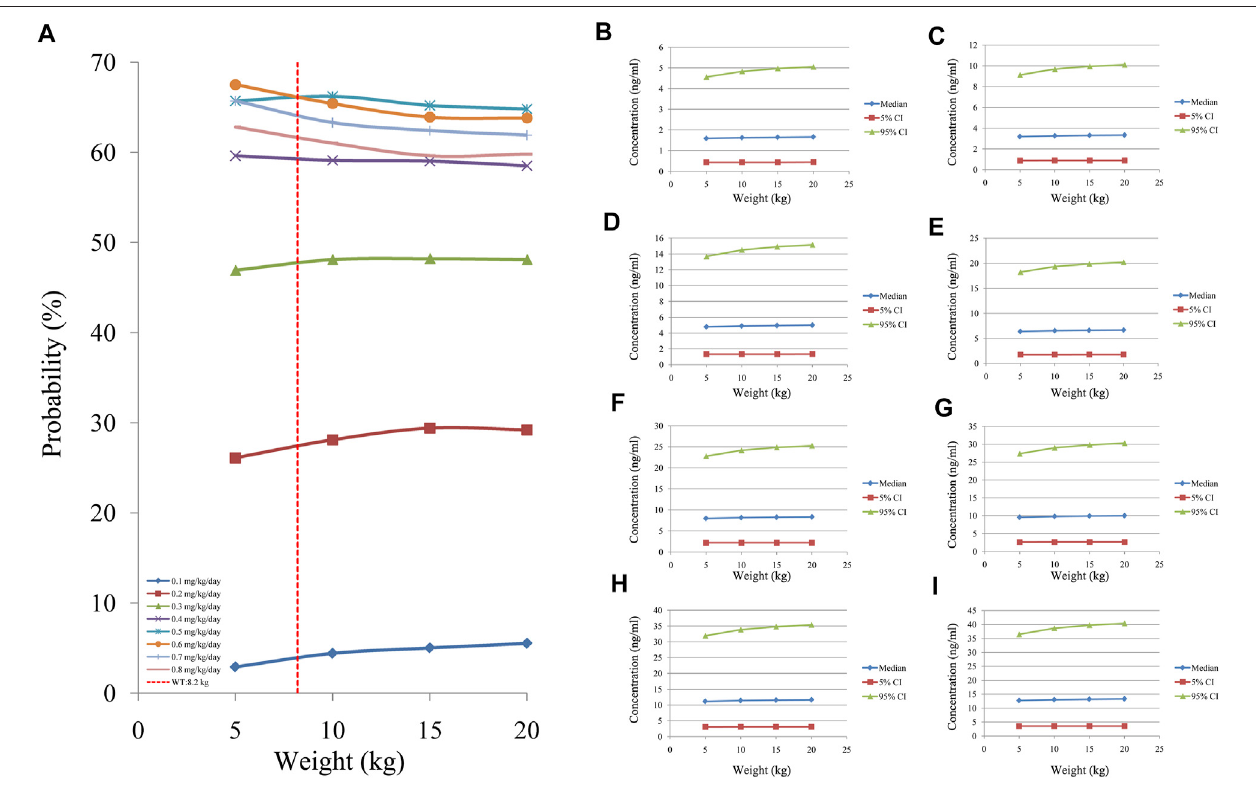
FIGURE 5| Probability of tacrolimus concentrations in CD children undergoing HSCT without posaconazole. (A) Probability of reaching tacrolimus concentrations (5 – 20 ng/ml). (B) 0.1 mg/kg/day tacrolimus-simulated concentrations. (C) 0.2 mg/kg/day tacrolimus-simulated concentrations. (D) 0.3 mg/kg/day tacrolimus- simulated concentrations. (E) 0.4 mg/kg/day tacrolimus-simulated concentrations. (F) 0.5 mg/kg/day tacrolimus-simulated concentrations. (G) 0.6 mg/kg/day tacrolimus-simulated concentrations. (H) 0.7 mg/kg/day tacrolimus-simulated concentrations. (I) 0.8 mg/kg/day tacrolimus-simulated concentrations. Median, 5% CI; 95% CI were median value, 5% and 95% con fi dence interval of 1000 times